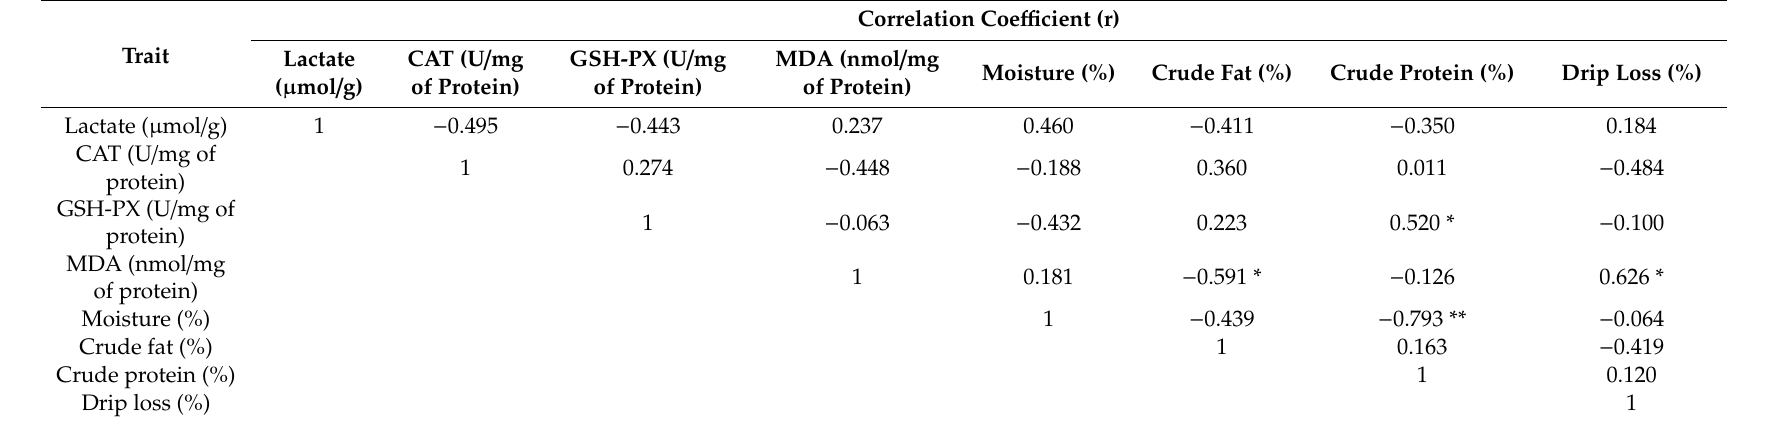
Table 7. Correlations among of glycolytic potential, antioxidant ability, and meat quality of breast